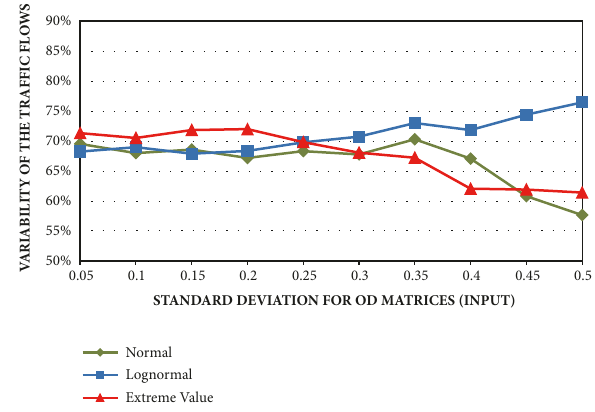
Figure 7: The relationship between the standard deviation for OD matrices (input) and the variability of the predicted traffic flows (output) for link No.